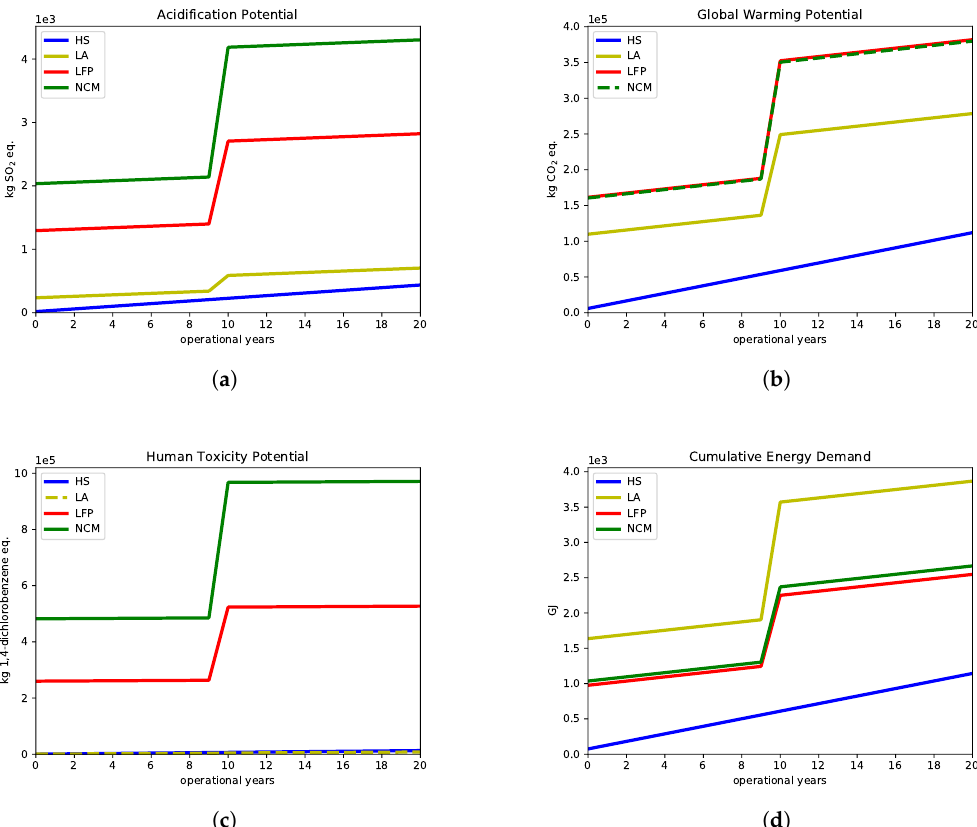
Figure 8. Analysis of use phase for pumped thermal energy storage and batteries per MWh storage capacity for: ( a ) AP; ( b ) GWP; ( c ) HTP and ( d )